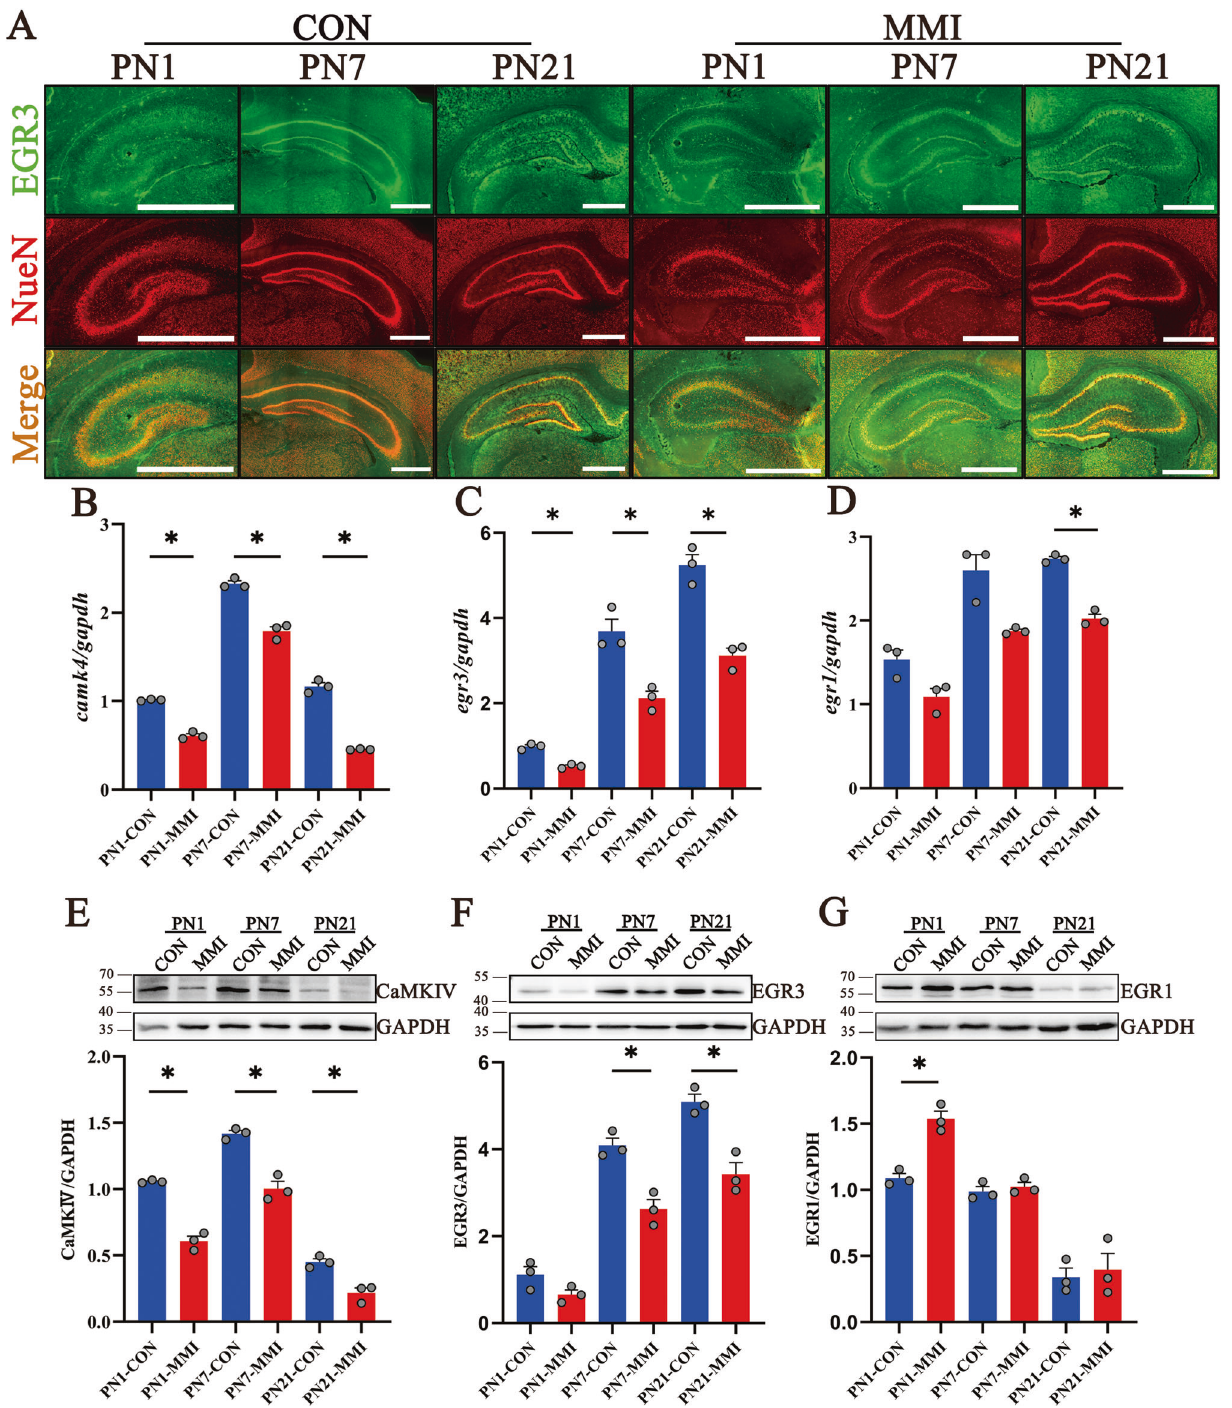
Fig. 4 CaMKIV/EGR3 was downregulated in the hippocampus of CH offspring. A The co-localization of EGR3 and NeuN-positive neurons in the hippocampus by immuno fl uorescence staining. CON indicates control, and MMI indicates CH. Scale bar: 1000 μ m. B – D The transcriptional levels of CaMKIV, EGR3, and EGR1 in the hippocampus of rat pups by RT-PCR. E – G The translational levels of CaMKIV, EGR3, and EGR1 by western blot. Experiments were performed in triplicates. Error bars represent the standard error (* P <